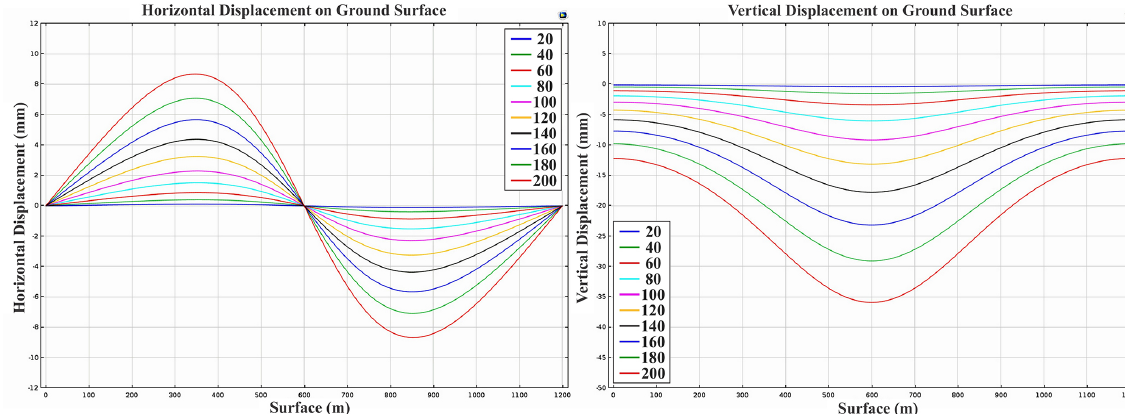
Figure 9. Horizontal and Vertical displacement of surface induced by a medium seated cavity.